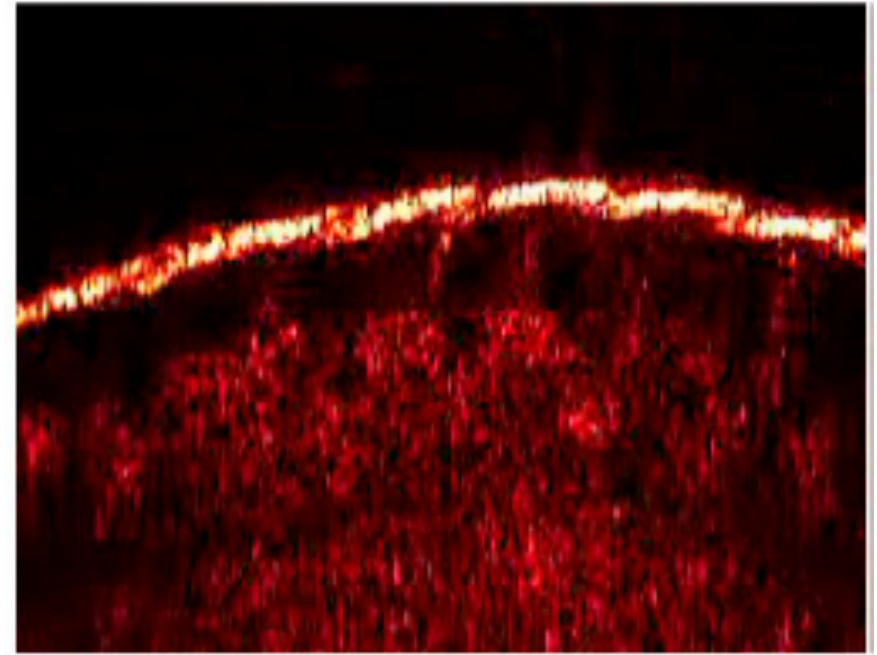
Figure 7. Reproduced with permission from Ref. [102]. An example B-scan taken from an in vivo image volume of a fingertip, captured with an LF AL pseudo-OCT system.